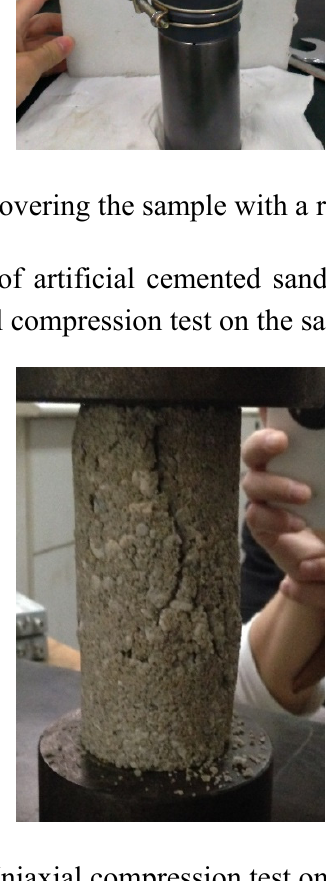
Figure 6. Uniaxial compression test on the